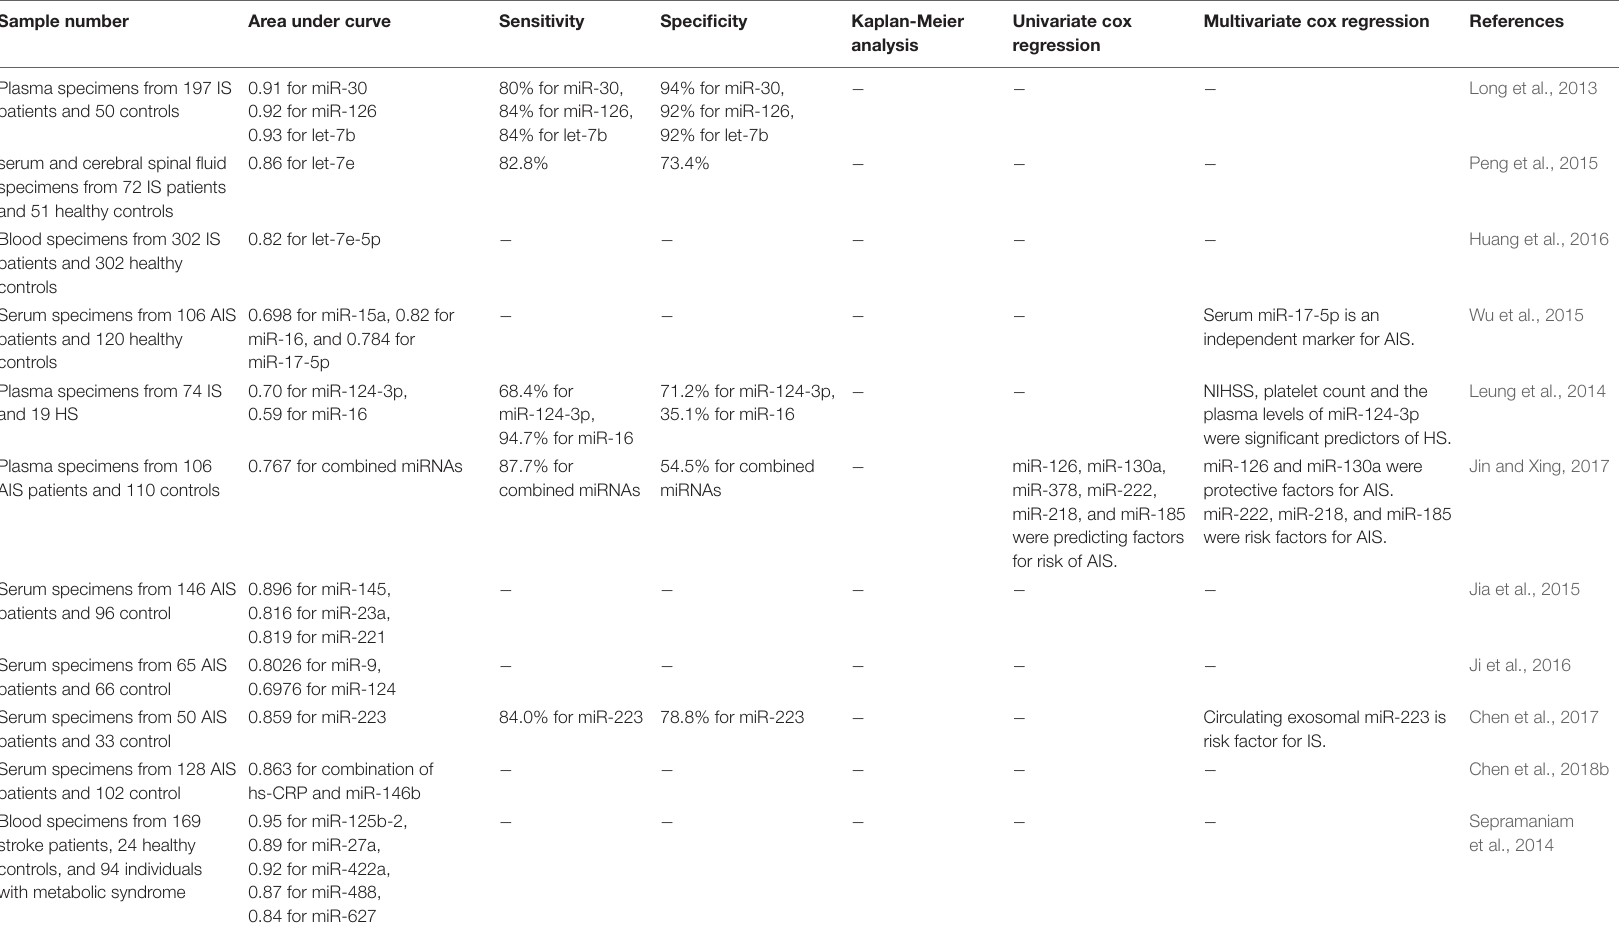
TABLE 6 | Diagnostic/prognostic role of miRNAs in IS. Sample